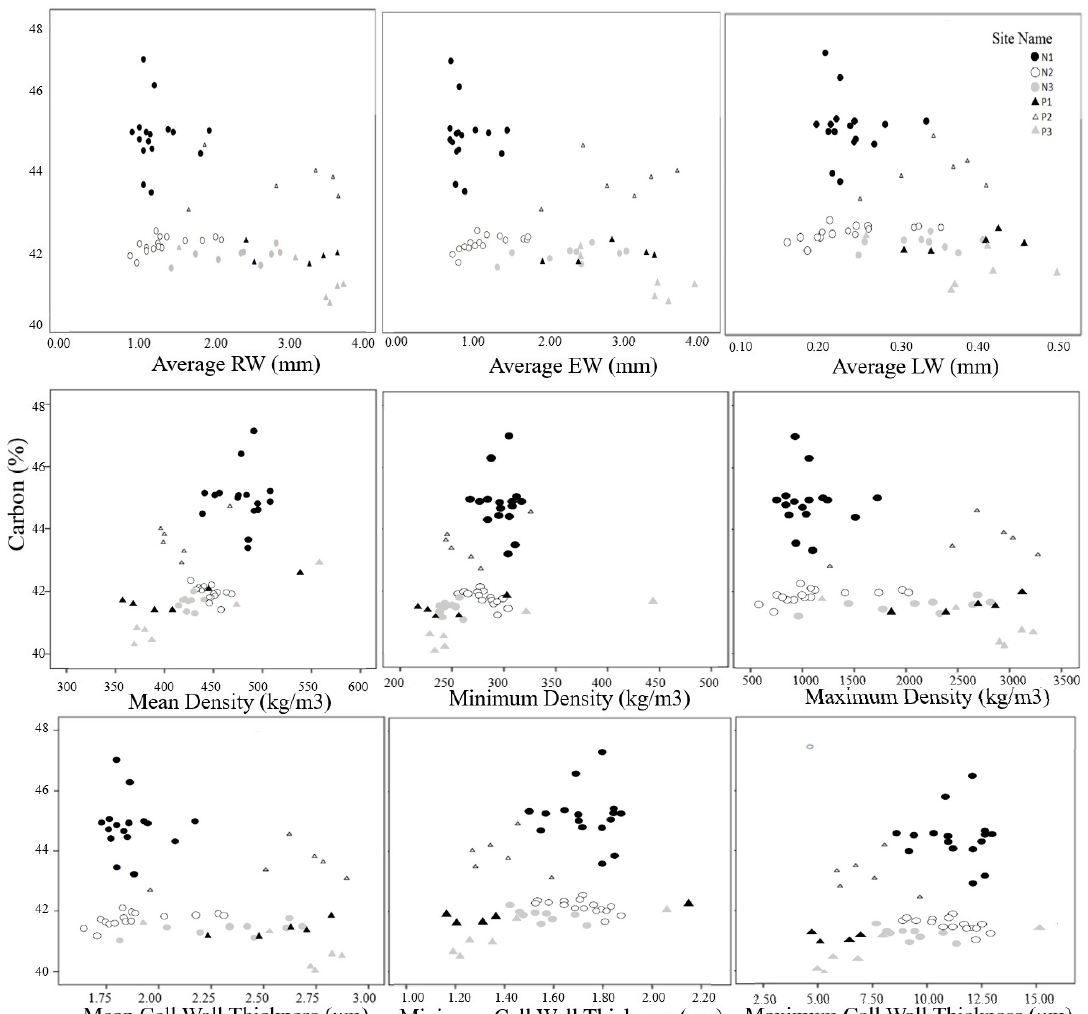
Figure 2. Comparison between the average percent (%) carbon (C) and ring width (RW), earlywood (EW), latewood (LW), and mean maximum minimum cell wall thickness (CWT) ( µ m) and density (D) (kg / m 3 ) values of the natural (N1, N2, N3) and planted (P1, P2, P3) hybrid white spruce stands depicted by colour and shape. Each point represents a 5 year average within each series for the percent carbon and wood properties. Note that not all the axes are at the same